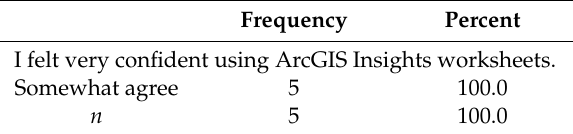
Table 11. Percentages and Frequencies, Q54.